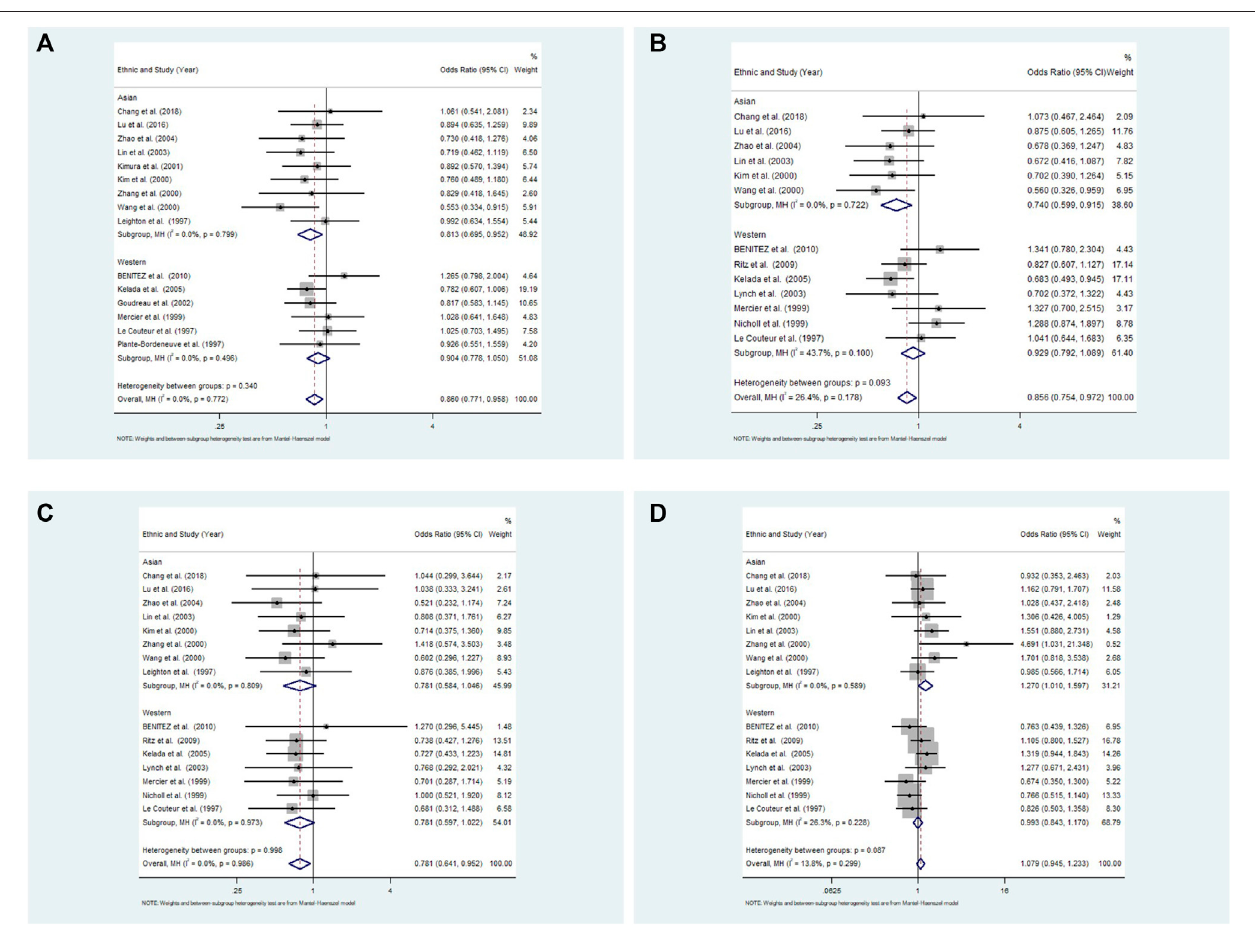
FIGURE 3 | Meta-analysis with a fi xed effects model for the association between the 3 ′ -UTR VNTR in SLC6A3 and PD susceptibility in Asian and Western populations. (A) Allele model, 10R vs. all others; (B) Pseudodominant model, 10R/10R + 10R/9R vs. all others; (C) Pseudorecessive model, 10R/10R vs. all others; (D) Pseudocodominant model, 10R/9R vs. all others OR: odds ratio, CI: con fi dence interval, I-squared: measure to quantify the degree of heterogeneity in meta-analyses.